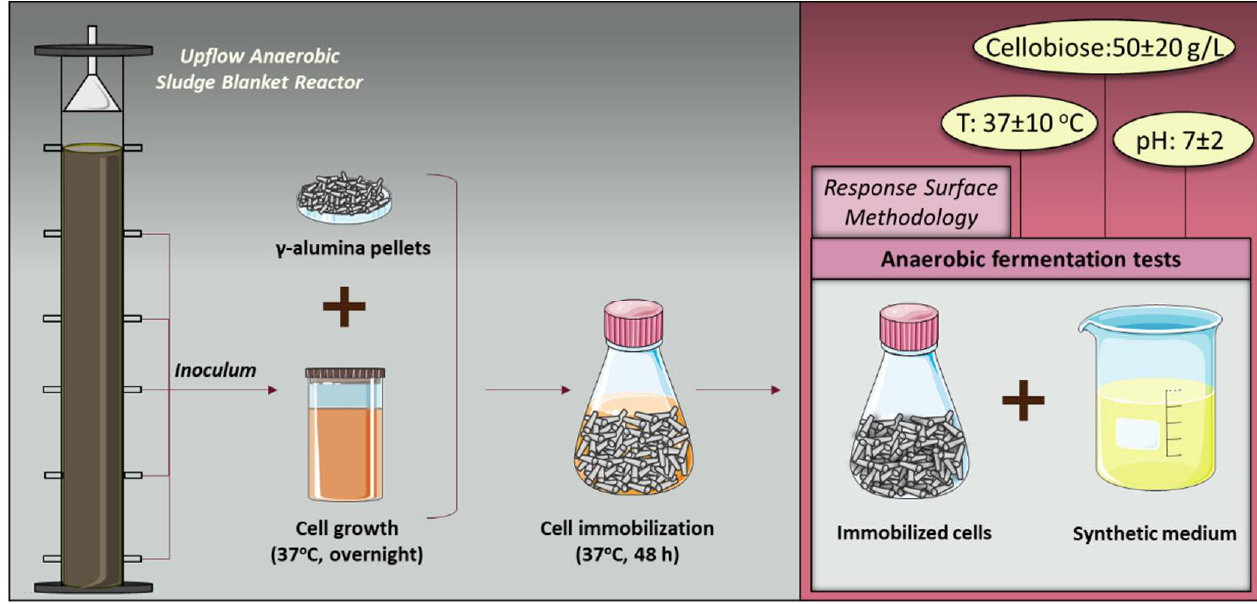
Figure 1. Experimental procedure of cell growth, cell immobilization on γ-alumina pellets, and anaerobic acidogenic fer- mentation.